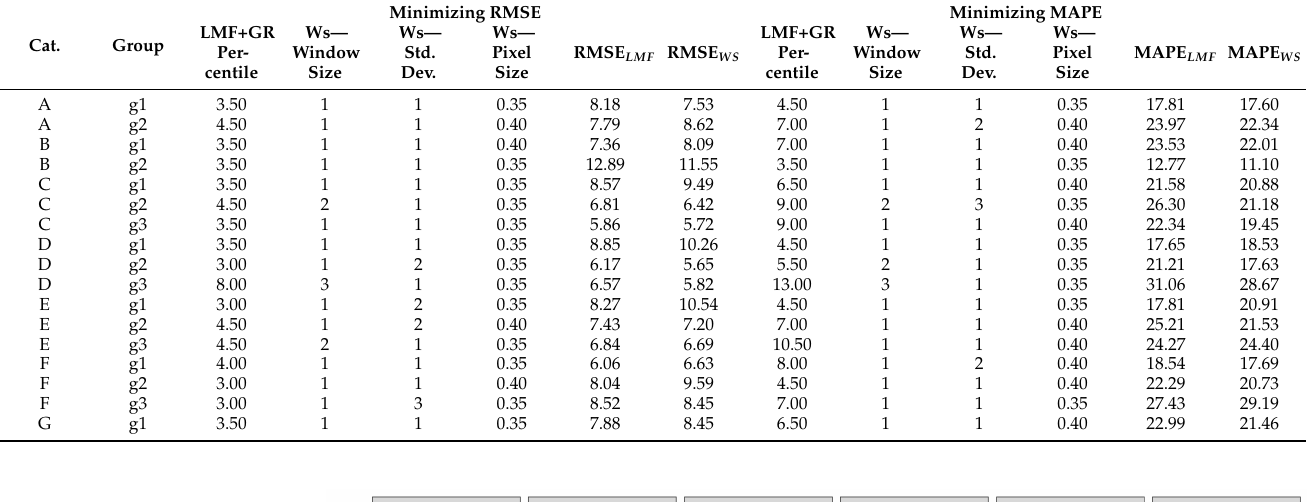
Table 3. Optimal parameter combinations in the ITD process that ensure minimum errors of the considered metrics for each category and group of sample plots. Window size and standard deviation parameters for Watershed (WS) method are presented in pixels, while pixel size is in meters. Categories and divisions into groups correspond to Table 2.